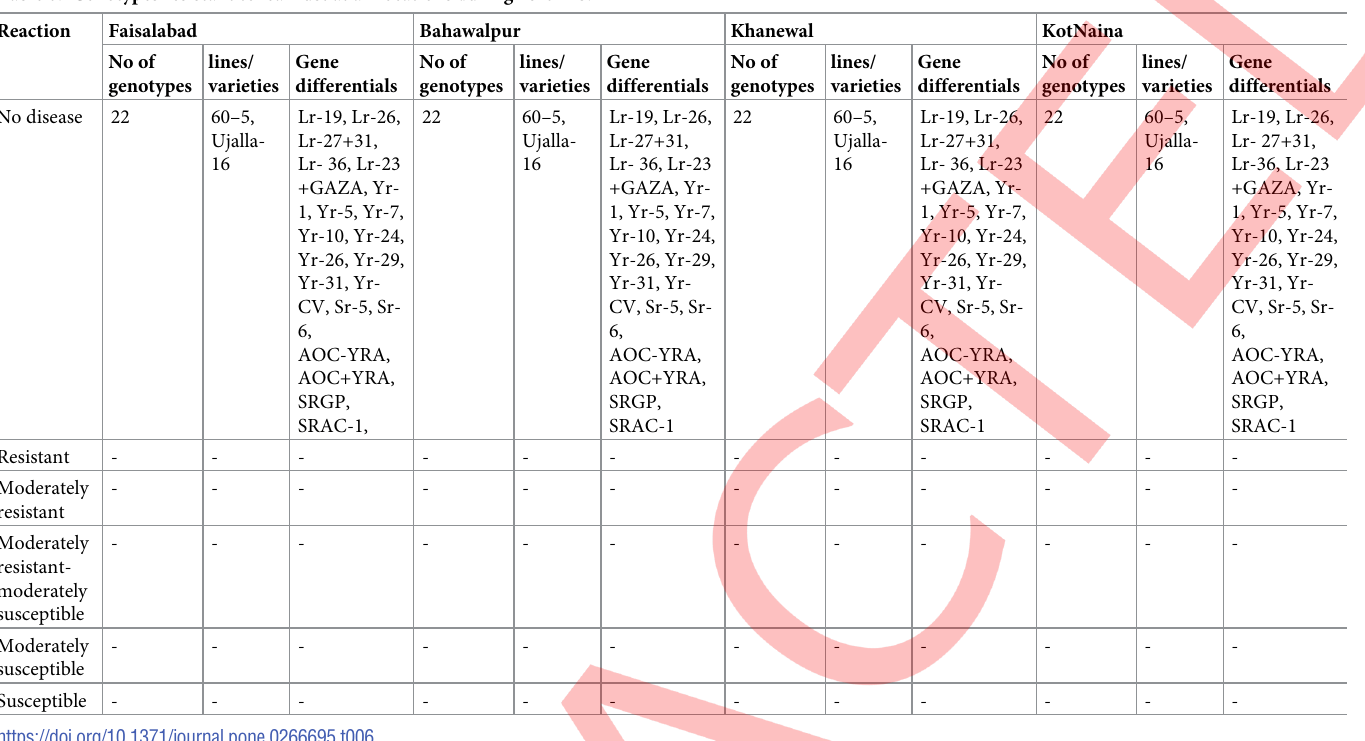
Table 6. Genotypes resistant to leaf rust at all locations during